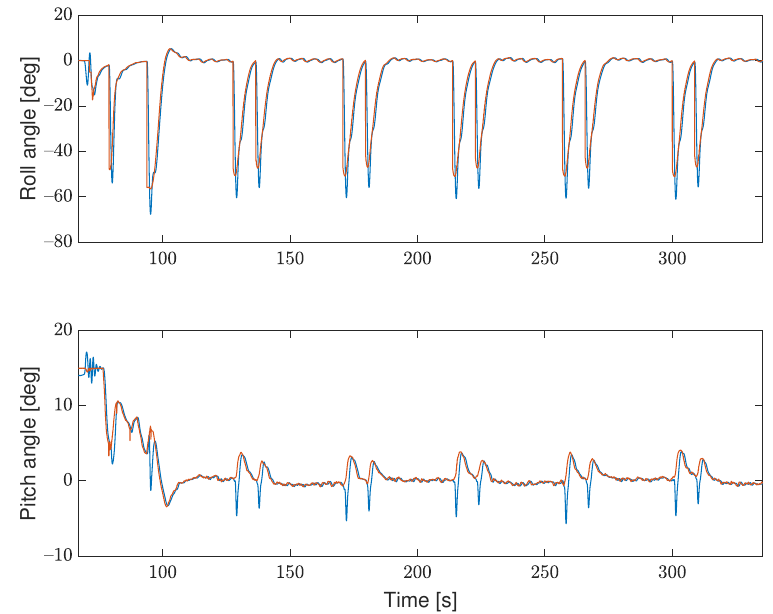
Figure 12. SITL: Roll and pitch angles (red) vs. reference angles